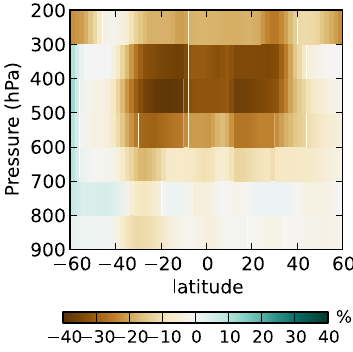
Figure 10. Annual mean percent change in specific humidity im- posed in the CO–OHSensQ experiment between 900 and 200hPa, 60 ◦ S–60 ◦ N.